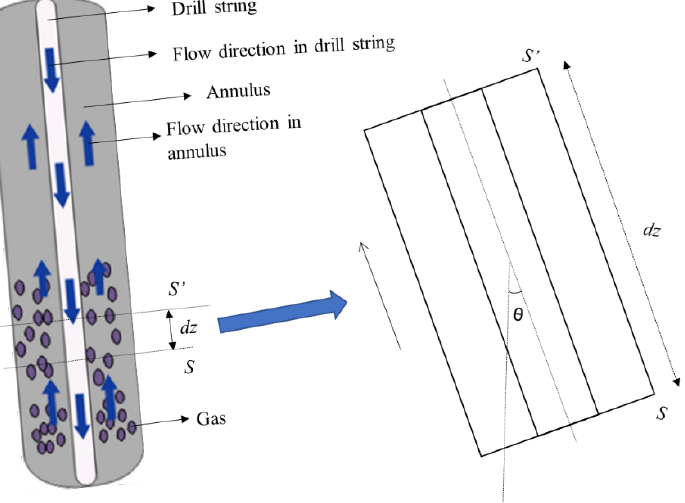
Figure 1. Schematic diagram of the wellbore multiphase flow and control body